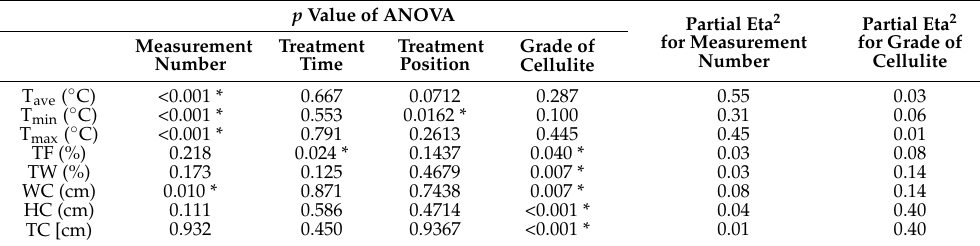
Table 2. Analysis of the statistical significance of differences between the surface temperature of the buttocks and thighs, selected body composition parameters, and circumferences measured in repeated measurements during 15-treatment vibration therapy (taking into account the position and duration of the procedure and the grade of cellulite). p Value of ANOVA Partial Eta 2 Partial Eta 2 for Measurement for Grade of CelluliteMeasurement Treatment Treatment Grade of Number Number Time Position Cellulite